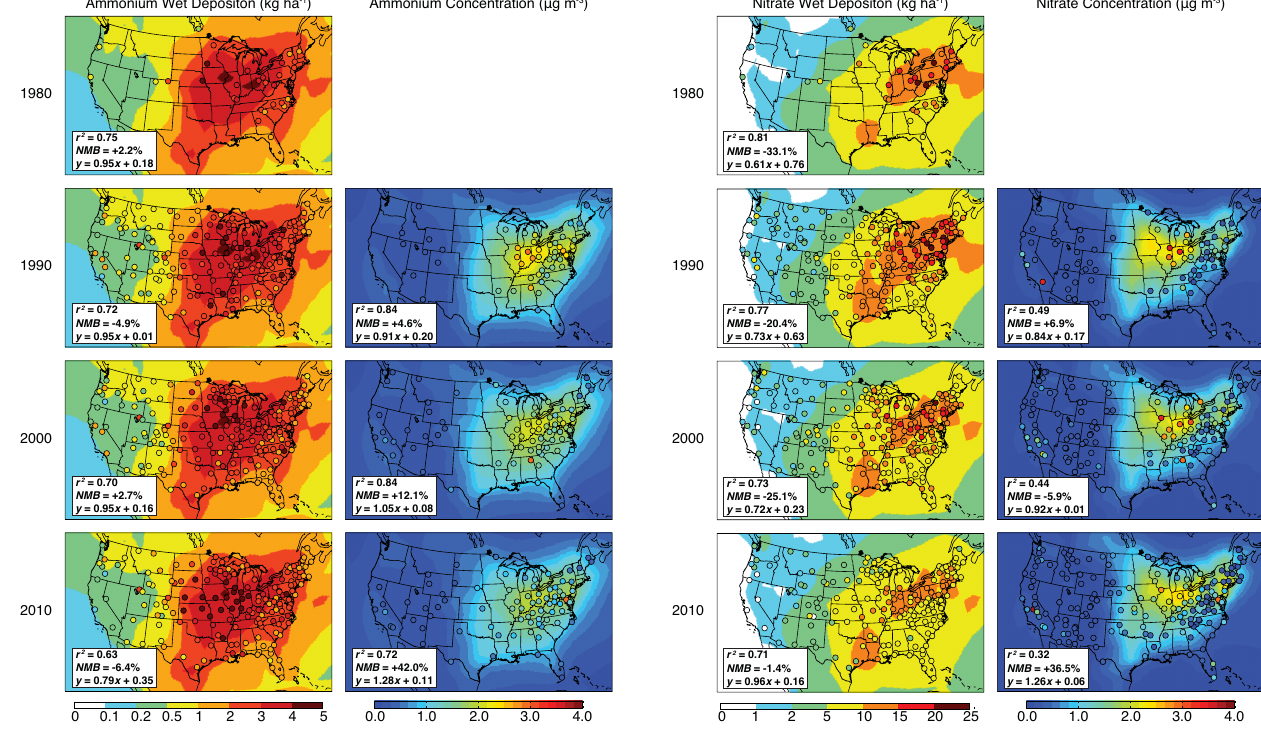
Fig. 4. Same as Fig. 2 but for ammonium. Fig. 5. Same as Fig. 2 but for